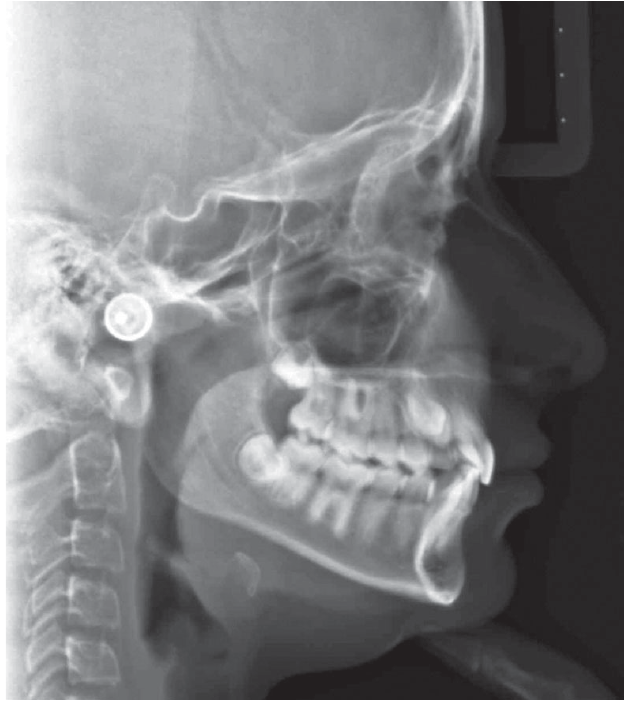
Fig. 5: Lateral cephalometric teleradiograph with impacted canines.